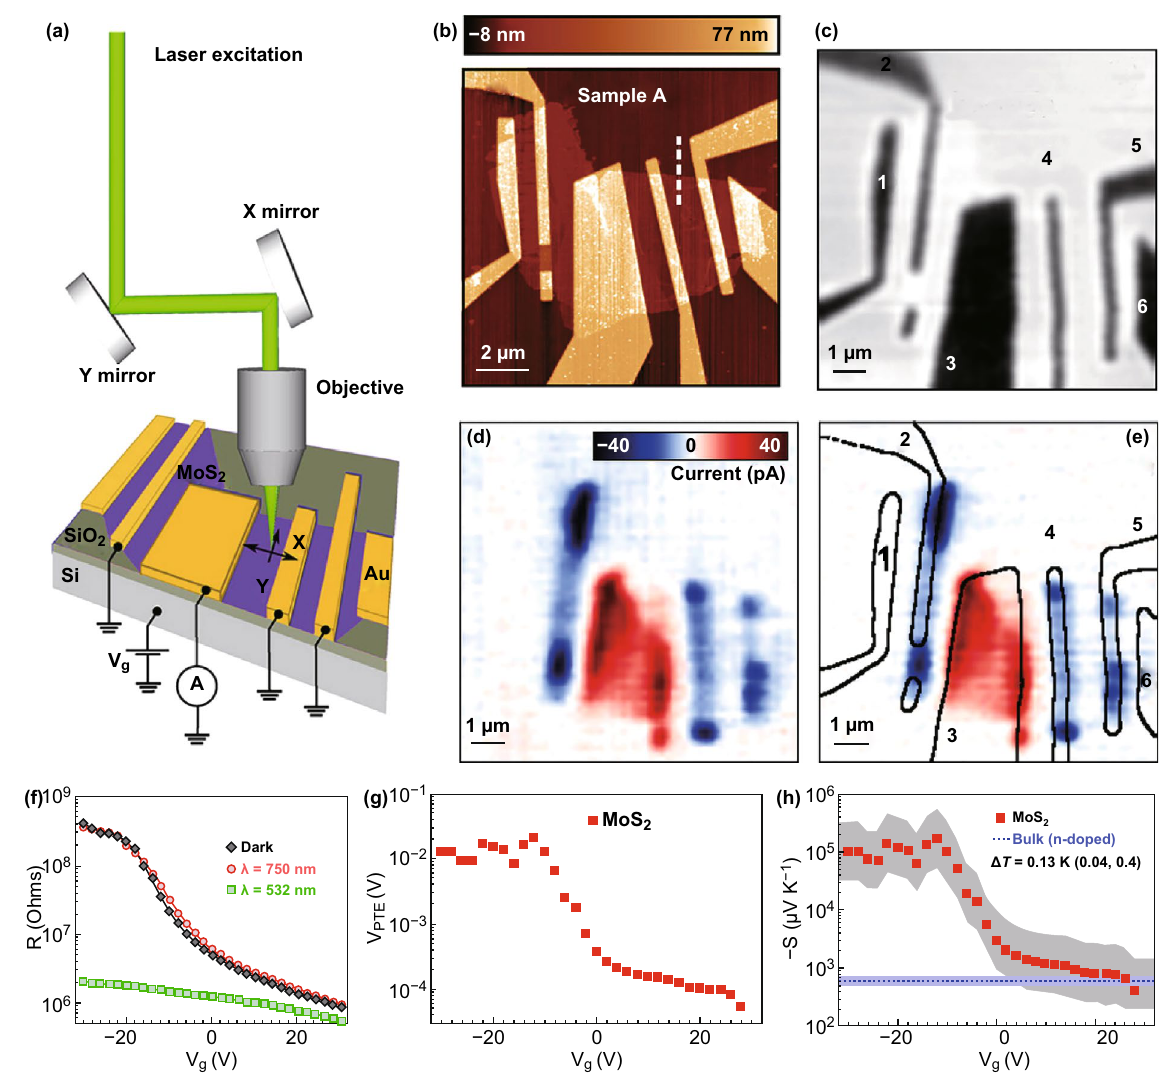
Fig. 18 a Schematic of the scanning photocurrent microscopy setup. b AFM image of the micro-devices with a MoS 2 flake. c Spatial map of the intensity of the reflected light from the device. d Photocurrent image of the MoS 2 FET. e Superposition of the photocurrent map and the con- tours of the electrodes, which were obtained from the light reflection map. f Resistance and g photothermoelectric voltage of the MoS 2 device as a function of the gate voltage in its dark state and with the laser spot placed on the MoS 2 /electrode interface. Estimated Seebeck coefficient as a function of the gate voltage. Reproduced with permission from Ref. [71]. Copyright 2013, American Chemical